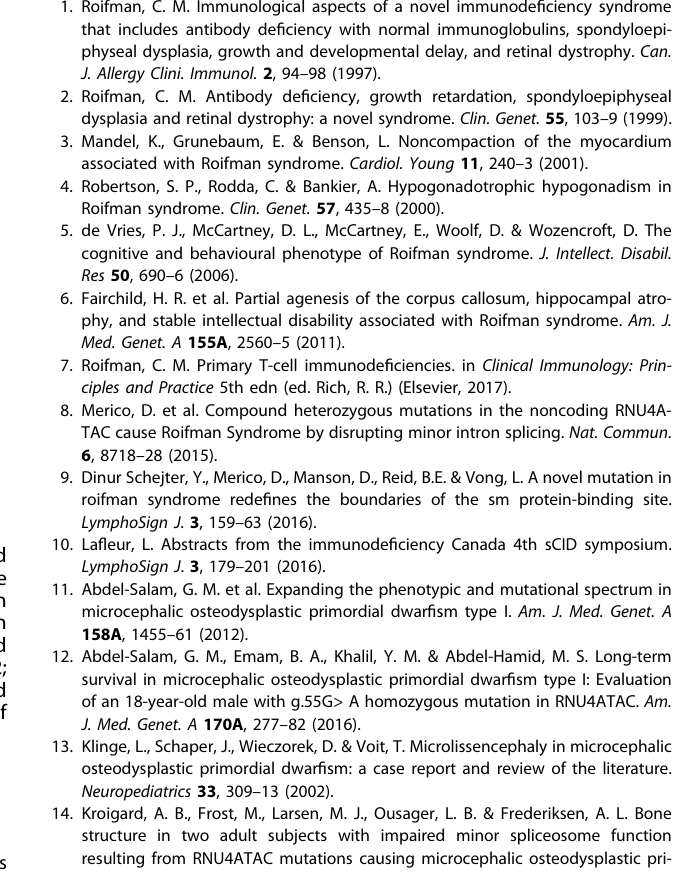
Fig. 6 Percentage intron retention (PIR) in patient 1 and unaffected family members. PIR across different introns is displayed as a boxplot: the affected patient 1 clearly displays greater minor intron retention than the unaffected wild-type siblings, whereas major intron retention levels are lower and similar across samples. Hom_RS-patient 1; Hom_CT1.nc-unaffected, non-carrier male sibling of patient 1, aged 3 months; Hom_CT2.nc-unaffected, non-carrier male sibling of patient 1, aged 9 years. Grey boxes – major intron retention levels, orange boxes – minor intron retention levels.